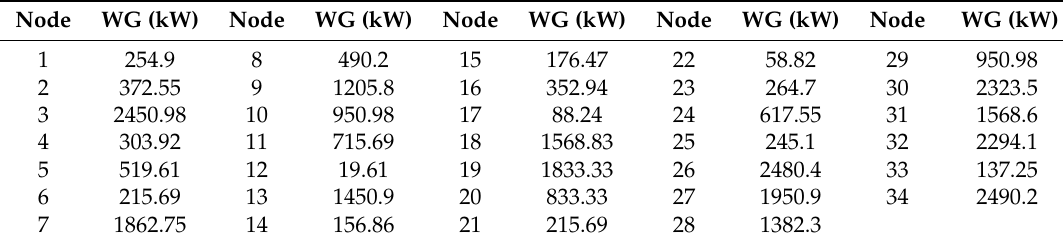
Table 8. Optimal WG Dispatch in Low EV